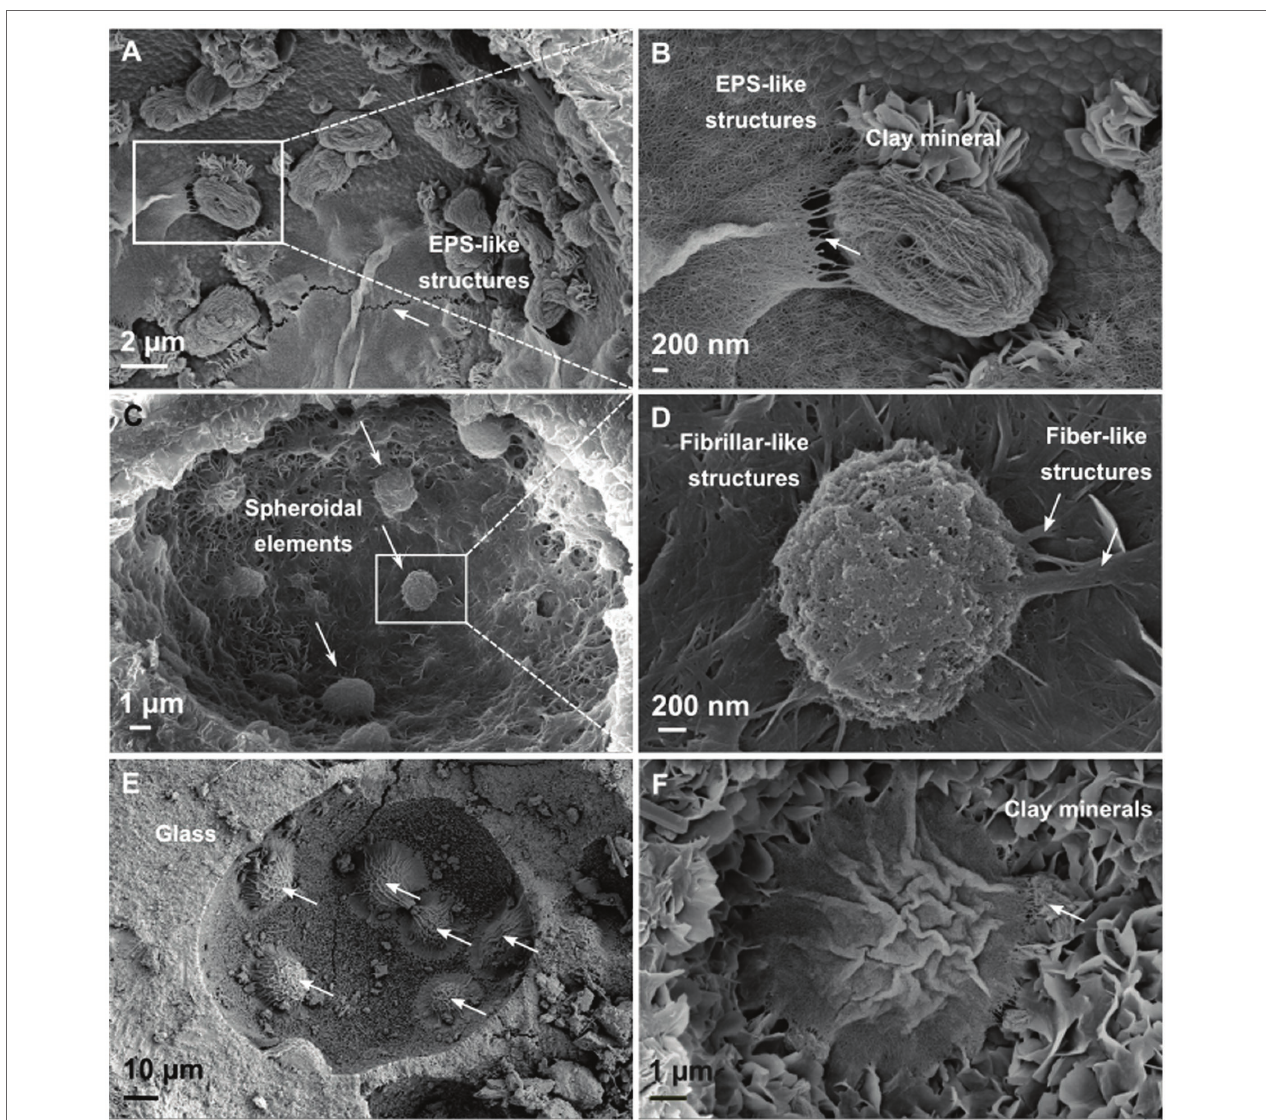
FIGURE 6 | Scanning electron micrographs of Surtsey tephra surfaces in drill core samples. (A,B) Platey clay mineral and EPS-like structures, 65 m b.s., sample C22. (C,D) Vesicle surfaces in altered basaltic glass are covered by a net of fibrillar-like structures that appears to be attached to spheroidal elements, 32 m b.s, sample C9. (E,F) Wrinkled dome structures, or mounds, are covered by a network of filaments, 65 m b.s, sample